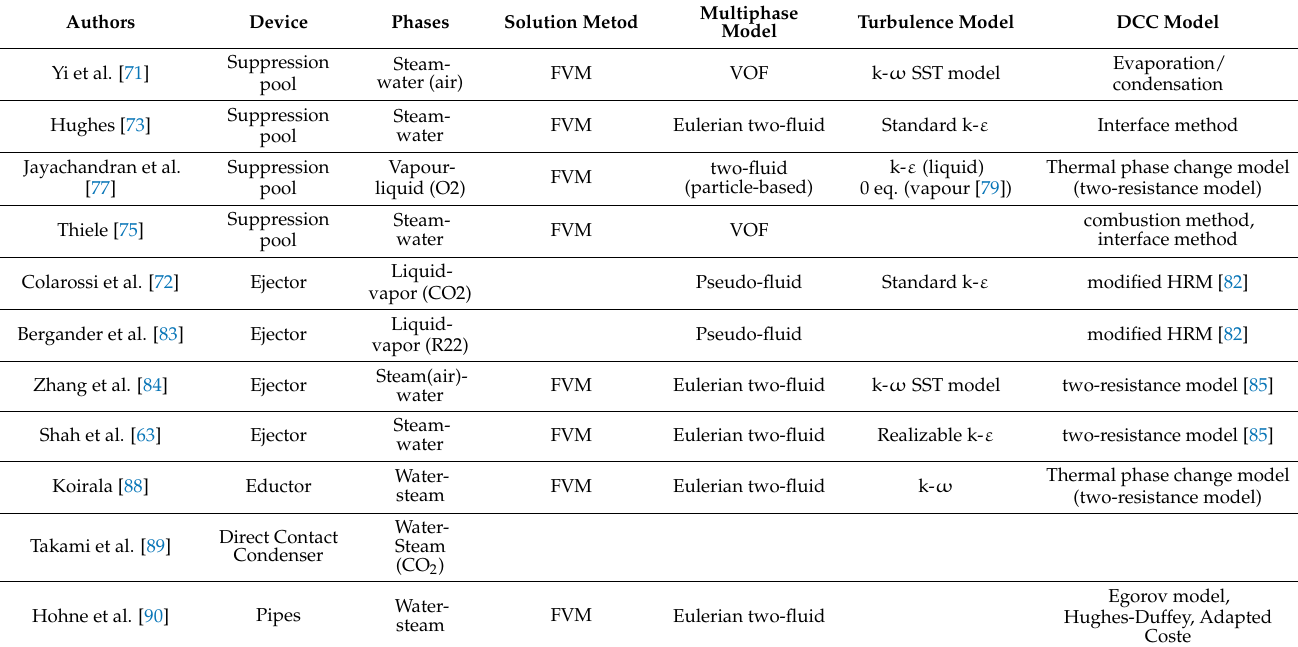
Table 25. Overview of direct contact condensation models.